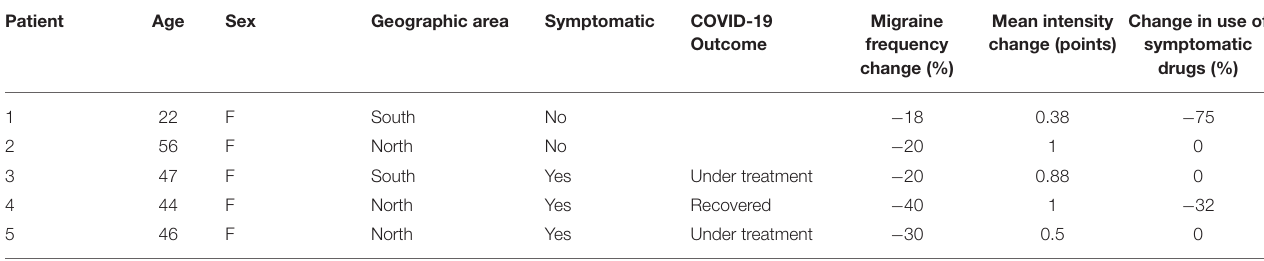
TABLE 4 | Characteristics of migraine patients positive to SARS-CoV-2 infection.